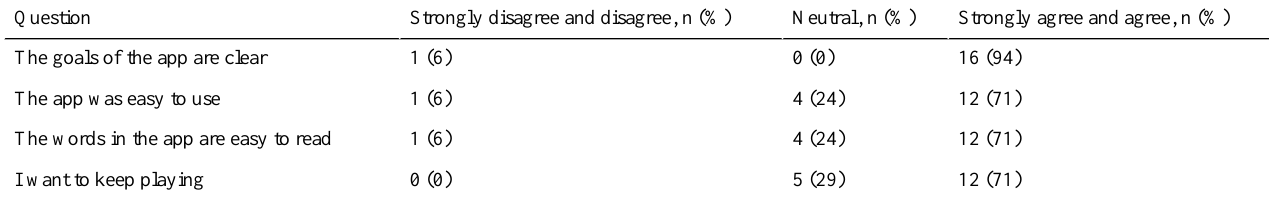
Table 5. Summary of quantitative data for user testing session 5 (N=17)